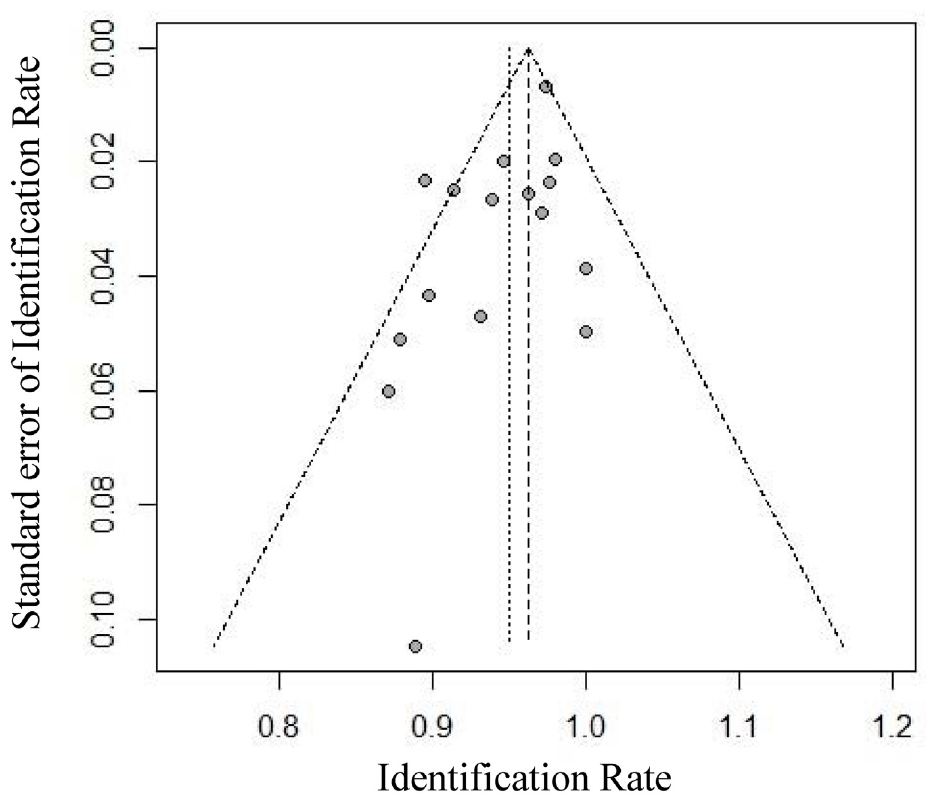
Fig 3. Funnel plot to assess the publication bias effect on the IR. Each dot represents a separate study. The funnel plot revealed no apparent evidence of publication bias.